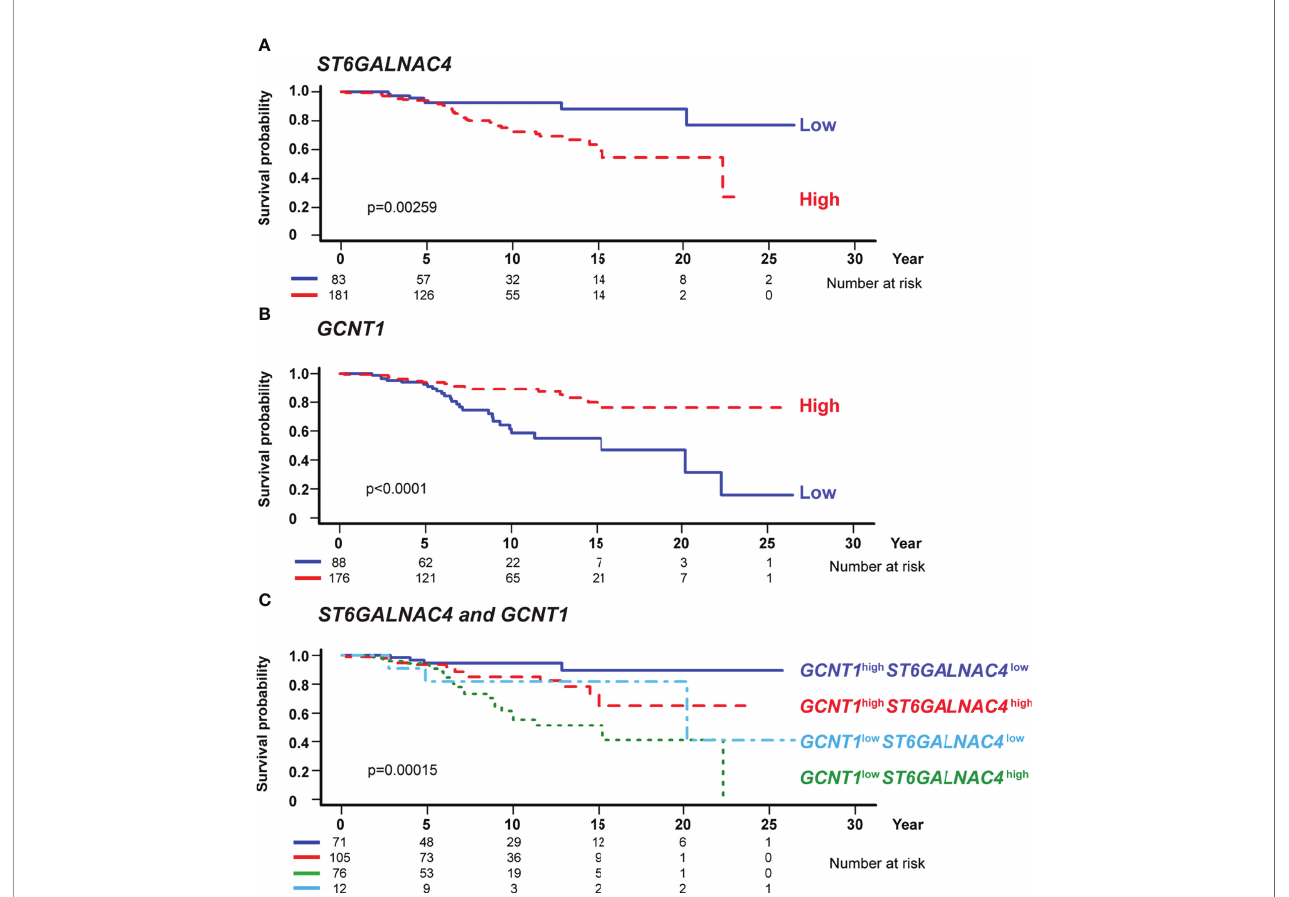
FIGURE 7 | GCNT1 and ST6GALNAC4 expression levels are associated with the prognosis of patients with chronic lymphocytic leukemia (CLL). Shown are the Kaplan – Meier survival plots with logrank test for two subgroups dichotomized with the expression levels of ST6GALNAC4 (A) and GCNT1 (B) as well as for four subgroups with the expression levels of both genes (C) using the optimal cutoff fi tted in the Cox proportional hazards model. High expression of ST6GALNAC4 (A) and low expression of GCNT1 (B) were associated with poorer prognosis in CLL patients ( P = 0.00259 and < 0.0001, respectively; likelihood ratio test). In panel (C) , the survival curves of four subgroups are signi fi cantly different ( P = 0.00015), and the prognosis of GCNT1 low ST6GALNAC4 high patients was signi fi cantly poorer as compared with that of GCNT1 high ST6GALNAC4 low patients ( P < 0.001, likelihood ratio test; see also Table 1